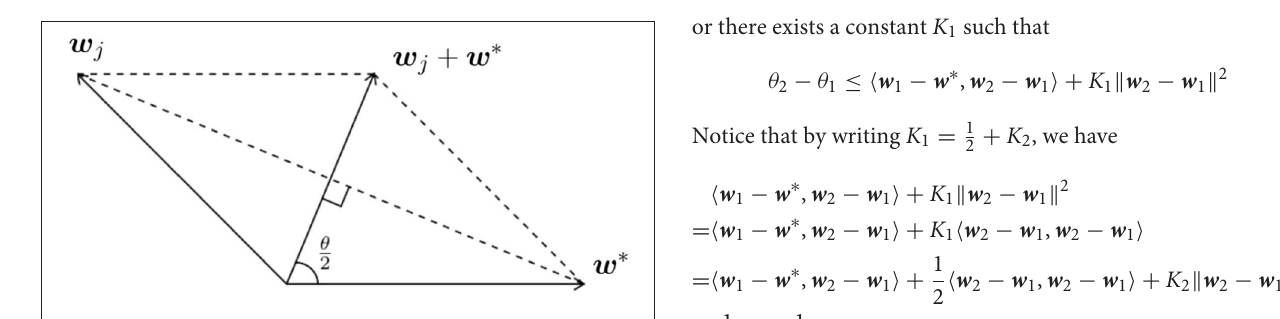
w t w ∗ k = 1. k k = k